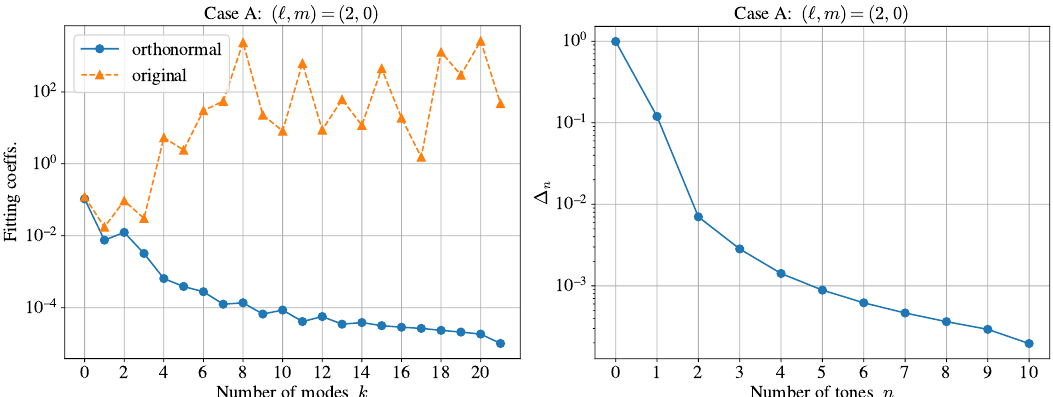
Figure 6. ( Left ) the absolute values of the fitting coefficients, ˜ C (cid:96) m for the ( (cid:96) = 2, m = 0 ) mode in case A, as a function of mode k . ˜ C (cid:96) m the least square fit of the TD data to the model in Equation (25). ( Right ) the estimator ∆ n in Equation (41) as a function of overtones n .